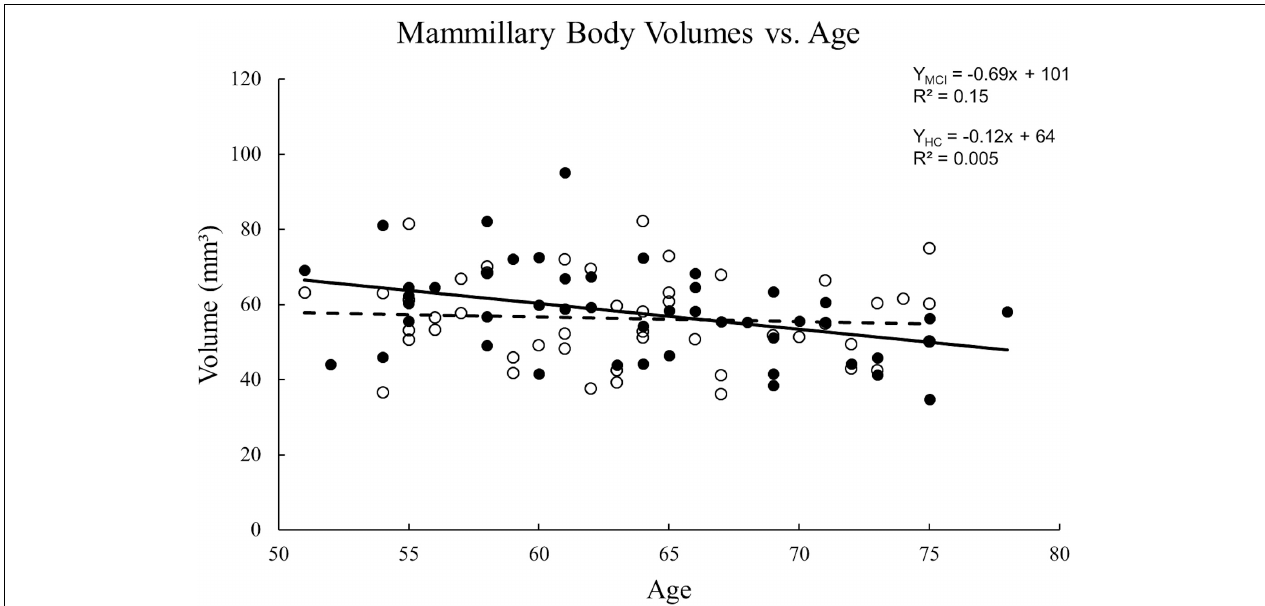
FIGURE 4 | Scatter plots and regression lines for the average mammillary body volume vs. age for 47 MCI patients and 47 HC subjects. Solid circles: MCI, Open circles: HC. Dotted line: HC, Solid line: MCI. There is a significant reduction in volume with age for MCI patients but not the